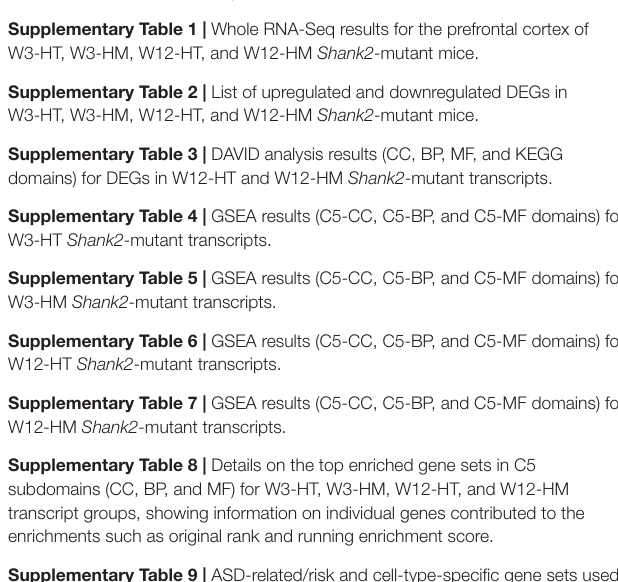
Supplementary Figure 8 | GSEA of transcriptomes from W12-HM Shank2 -mutant mice for biological functions in the C5-BP (biological process) domain. (A,B) GSEA results for W12-HM transcripts (A) and their integrated visualization generated using Cytoscape EnrichmentMap App (B) ( n = 4 mice for WT, HT, and HM, FDR < 0.05). Supplementary Figure 9 | GSEA of transcriptomes from W12-HM Shank2 -mutant mice for biological functions in the C5-MF (molecular function) domain. (A,B) GSEA results for W12-HM transcripts (A) and their integrated visualization generated using Cytoscape EnrichmentMap App (B) ( n = 4 mice for WT, HT, and HM, FDR < 0.05). Supplementary Table 1 | Whole RNA-Seq results for the prefrontal cortex of W3-HT, W3-HM, W12-HT, and W12-HM Shank2 -mutant mice. Supplementary Table 2 | List of upregulated and downregulated DEGs in W3-HT, W3-HM, W12-HT, and W12-HM Shank2 -mutant mice. Supplementary Table 3 | DAVID analysis results (CC, BP, MF, and KEGG domains) for DEGs in W12-HT and W12-HM Shank2 -mutant transcripts.